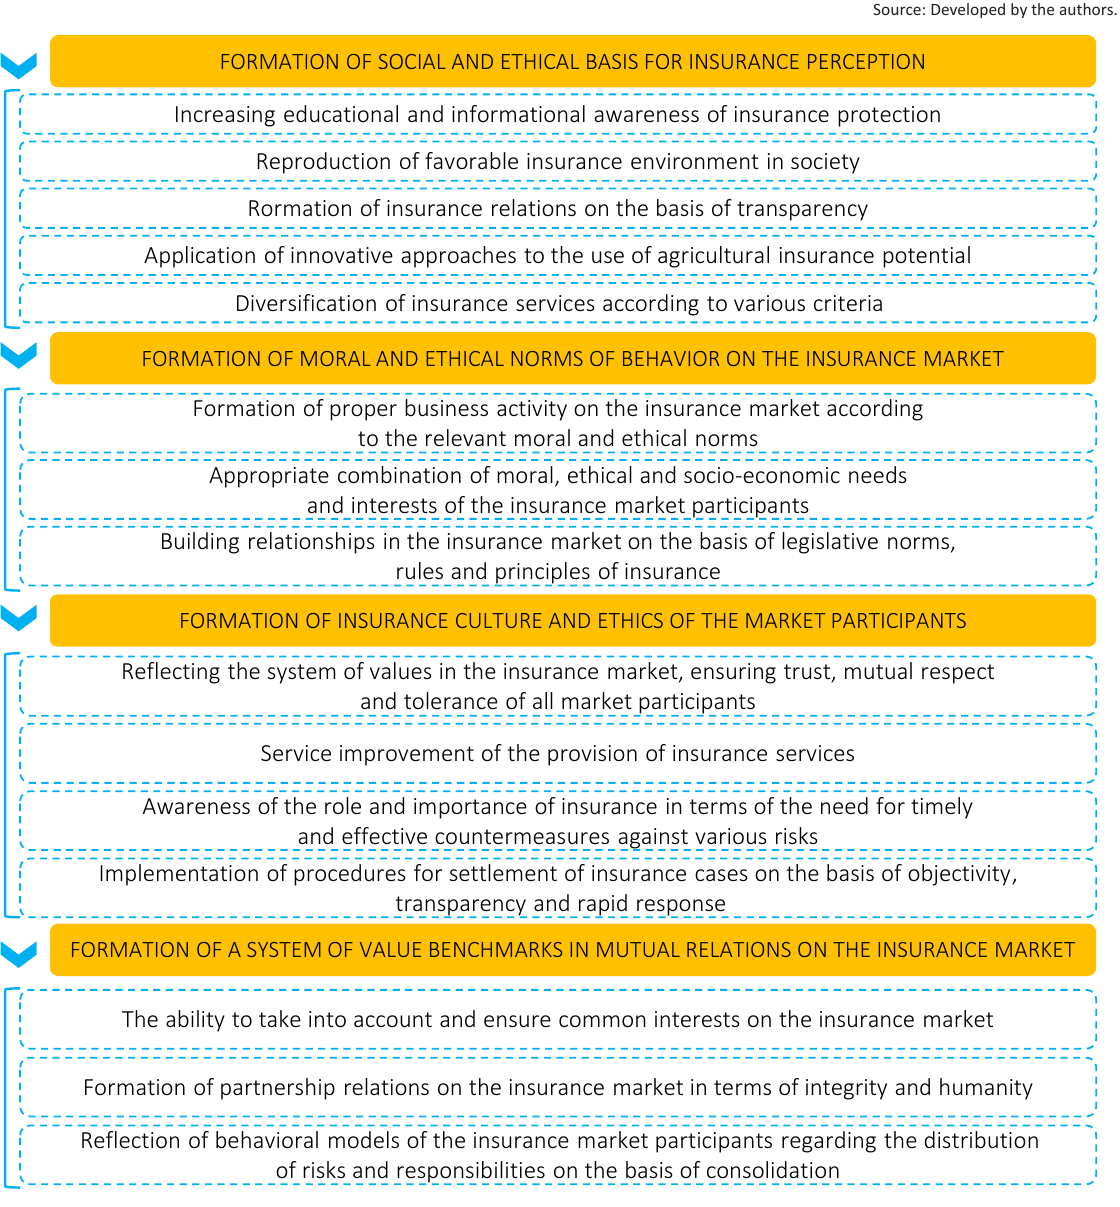
Figure 12. Model of formation of social responsibility of insurance market